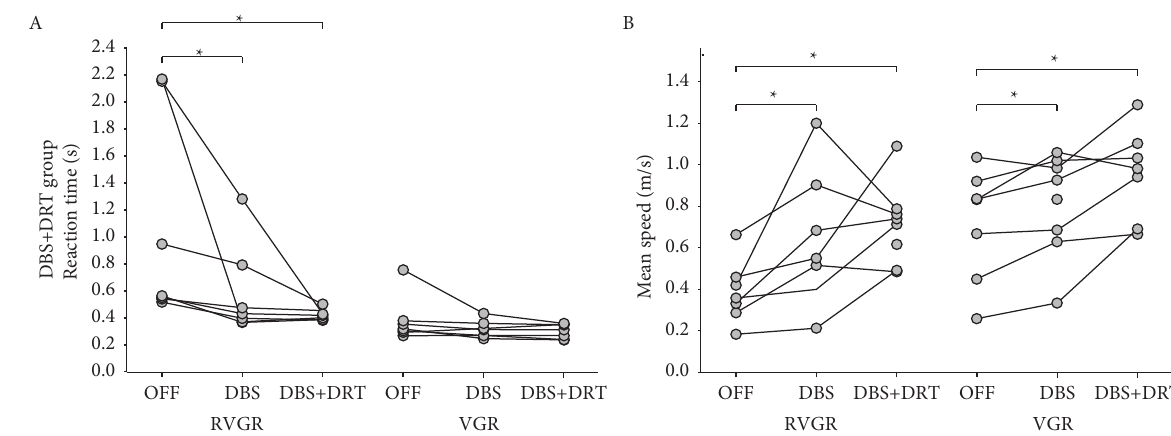
Figure 4: DBS +DRT group performance. (a) Reaction times were reduced by DBS and by DBS+ DRT during RVGR ( ∗ P < 0 . 05) but not during VGR. (b) Mean speeds were increased by DBS and by DBS+ DRT during RVGR ( ∗ P < 0 . 05) and during VGR ( ∗ P < 0 .